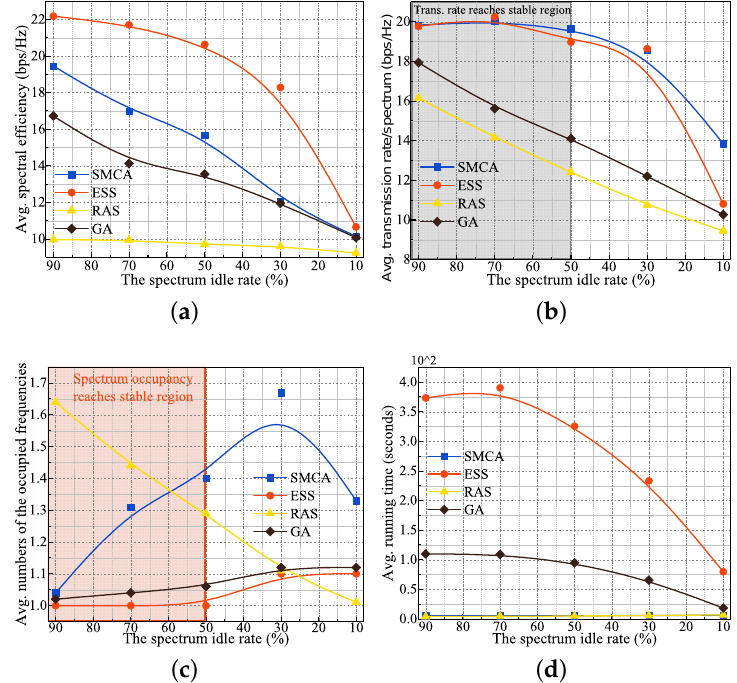
Figure 4. Performance results of the involved algorithms under different spectrum idle rates in a one-hop scenario. ( a ) spectrum efficiency ( b ) one-hop transmission rate ( c ) number of spectra occupied ( d ) execution